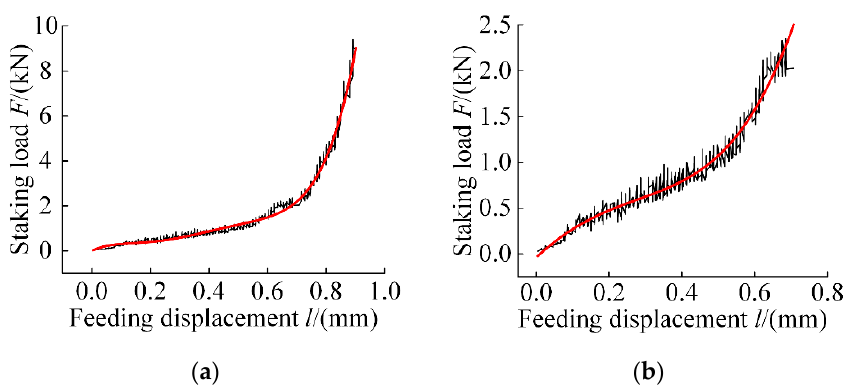
Figure 8. Relationship curve between the feeding displacement and the staking load: ( a ) the whole process of downward to “State 5”; ( b ) the process of downward to “State 3”.